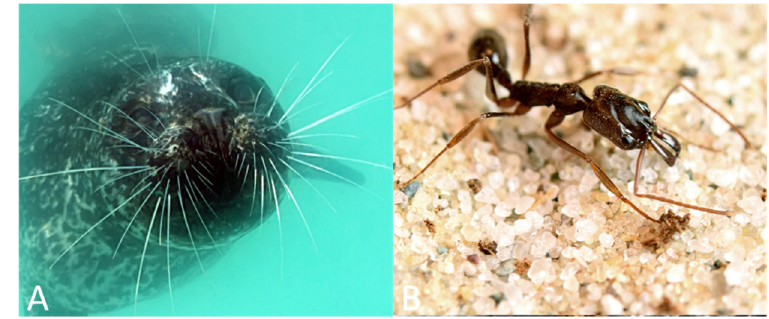
Figure 3. Hairs and hair-like structures aid in prey capture and foraging. ( A ) Harbor seal ( Phoca vitulina ) facial vibrissae, with a caudal curvature to their whiskers. These hairs aid in both navigation and foraging to detect the movement of prey (image modified from [109]). ( B ) Worker trap jaw ants ( Odontomachus brunneus ) use their powerful mandibles to capture food or escape danger. Hair triggers enable rapid closure of these mandibles image modified from [110]).